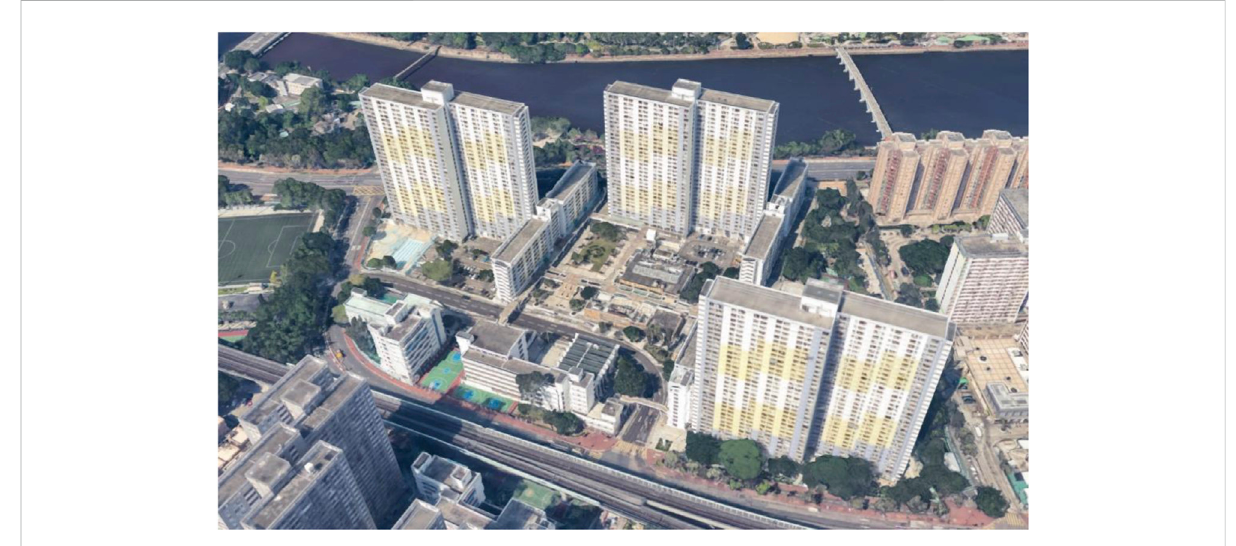
FIGURE 2 Jat Min Chuen estate in Shatin, Hong Kong. Image: Google